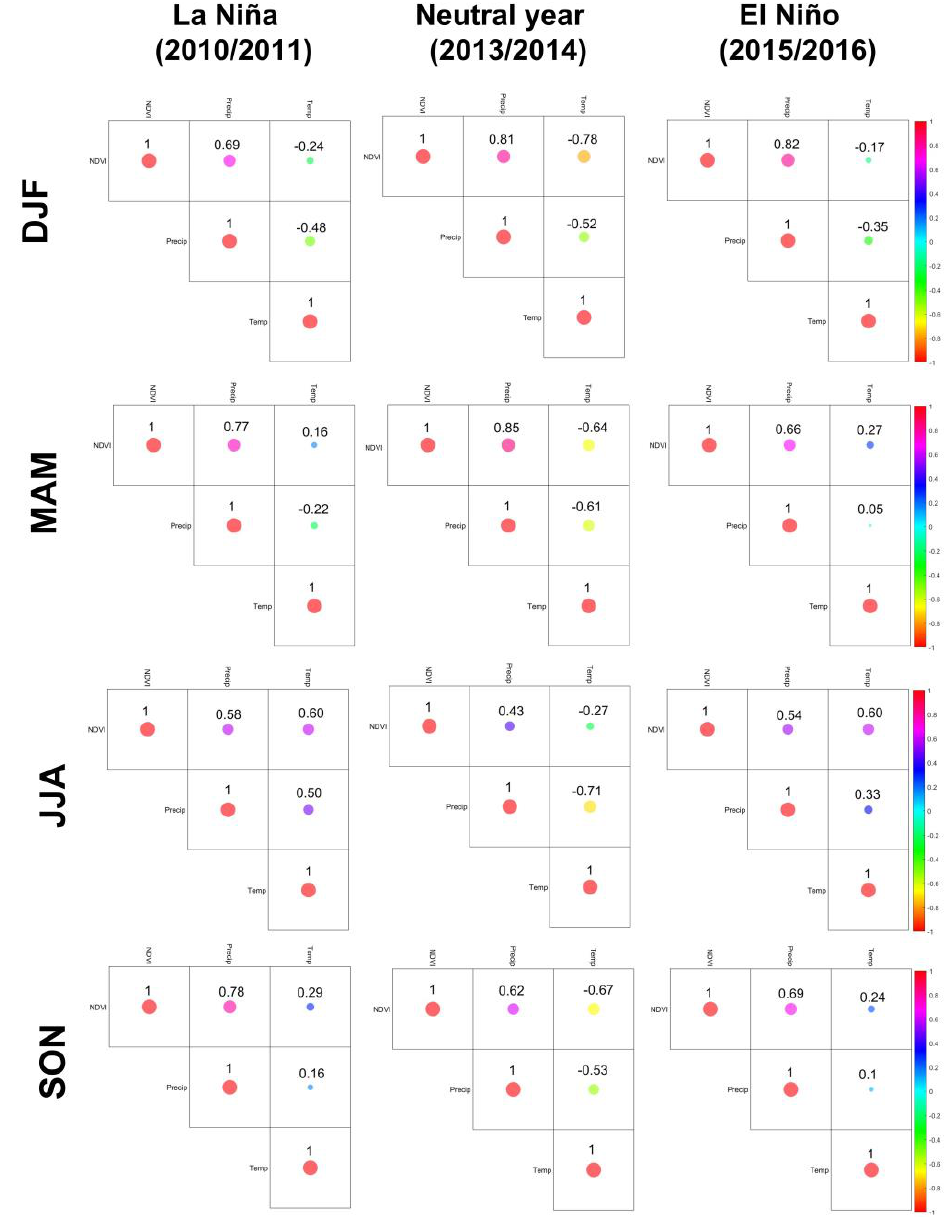
Figure 7. The relationship between precipitation (Precip), temperature (Temp), and NDVI during the La Niña, neutral year , and El Niño phases using the Pearson’s correlation.